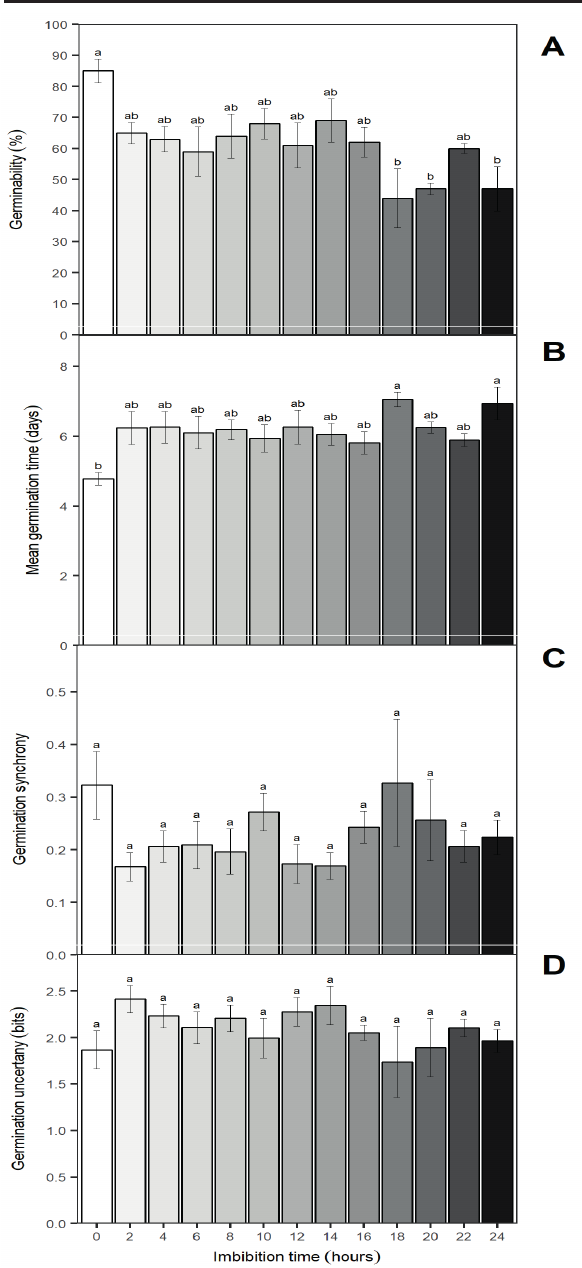
Figure 2 Germination response in Jatropha curcas seeds after different imbibition times. (A) Germination (%); (B) Mean germination time (days); (C) Germination synchrony and (D) Germination uncertainty (bits). The letter represent the mean difference with Student-Newman-Keuls test (p = 0.05). Means are represent with (±SE). n = 4.